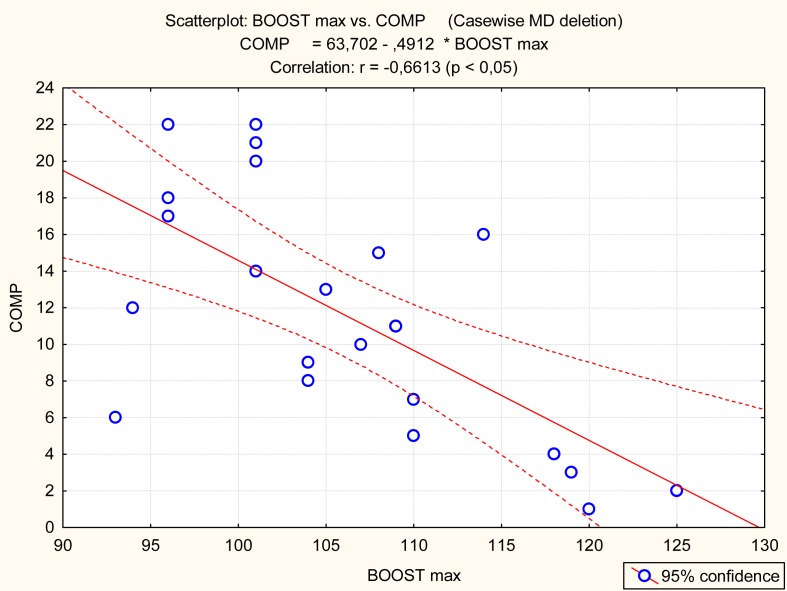
Graphical presentation of the relationship between Boost (BOOST max) and competitive achievement (COMP)